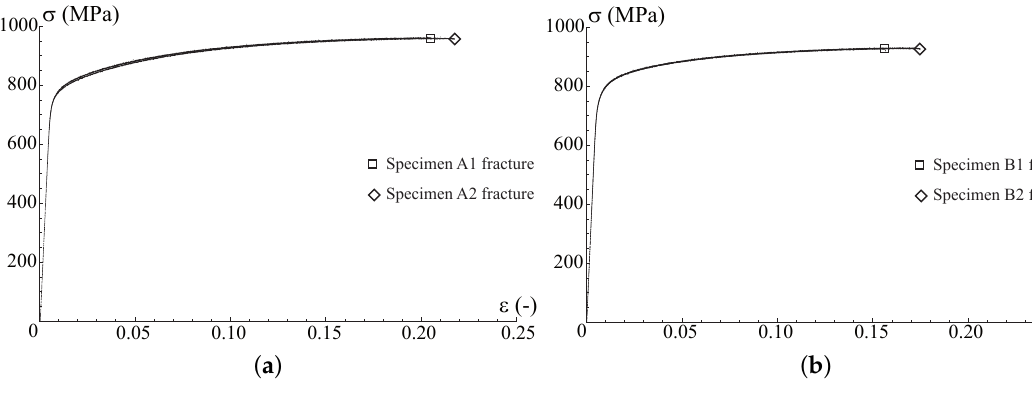
Figure 3. Tensile test characteristics. ( a ) Tensile tests– Bar A ; ( b ) Tensile tests– Bar B . Table 3. Material parameters computed on the basis of tensile